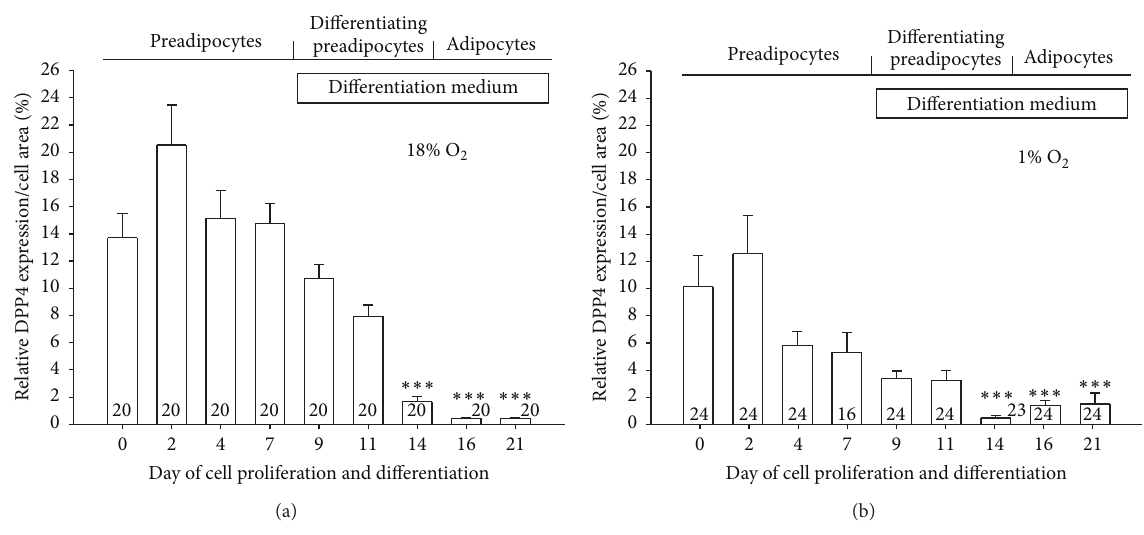
Figure 3: Differentiation-dependent expression density of membrane DPP4 of human preadipocytes and adipocytes cultured in vitro under different environmental conditions. Relative expression density of DPP4 in human preadipocytes in the course of differentiation to mature adipocytes cultured in normoxia (a) and hypoxia (b). Data are presented as mean values ± SE. Numbers denote the number of cells imaged ( ∗∗∗ 𝑃 ≤ 0.001 versus preadipocytes on day 0; one-way ANOVA on ranks). On day 0, cells were already